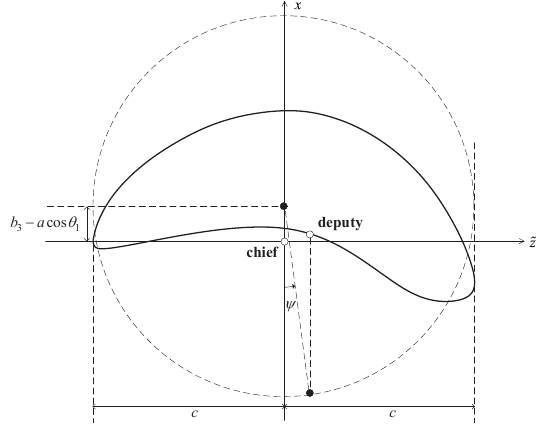
Figure 6. Illustration of the scale-independent relative orbital elements ( x − z